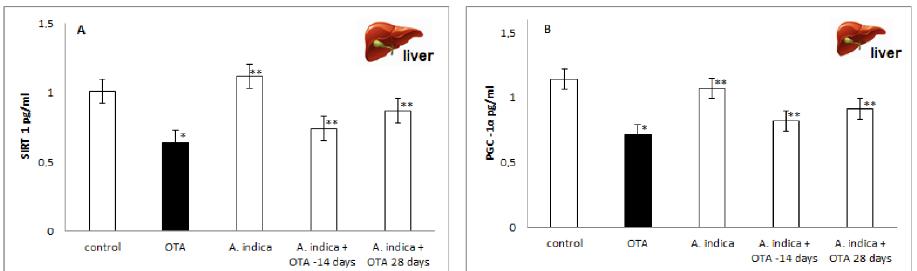
Figure 3. The effects on SIRT1 ( A ) and PGC- 1α pathway ( B ) in four group of mice ( n = 6) treated with A. indica oil, OTA, and combination of A. indica + OTA all results were compared to controls (non-treated mice). The results are expressed in µg/g tissue hydroxyproline. Values are presented as mean ± SEM. The statistically significant difference used in relation to controls (*); p <0.05 vs. controls, (**) p <0.05 vs. OTA treated mice.